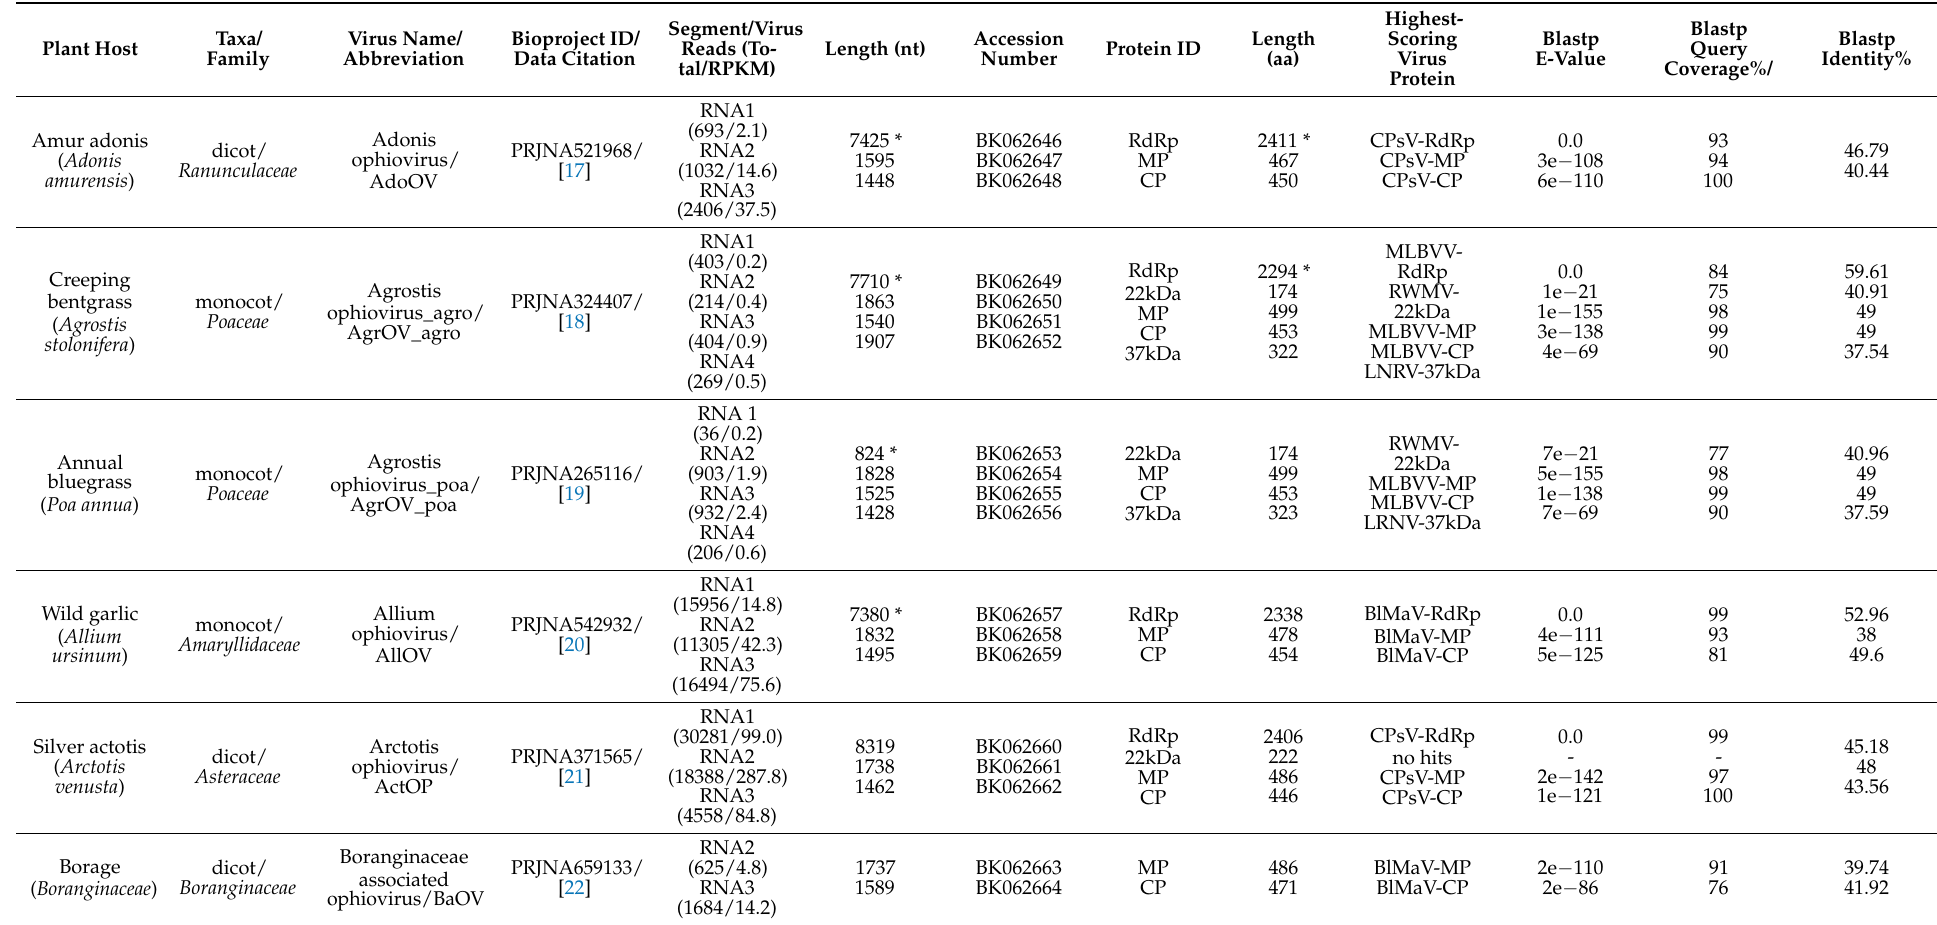
Table 1. Summary of novel ophioviruses identified from plant RNA-seq data available in the NCBI database. Acronyms of best hits are listed in Supplementary Table